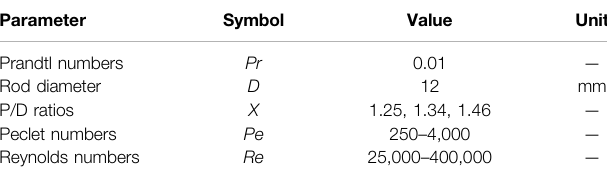
TABLE 4 | Flow parameters.